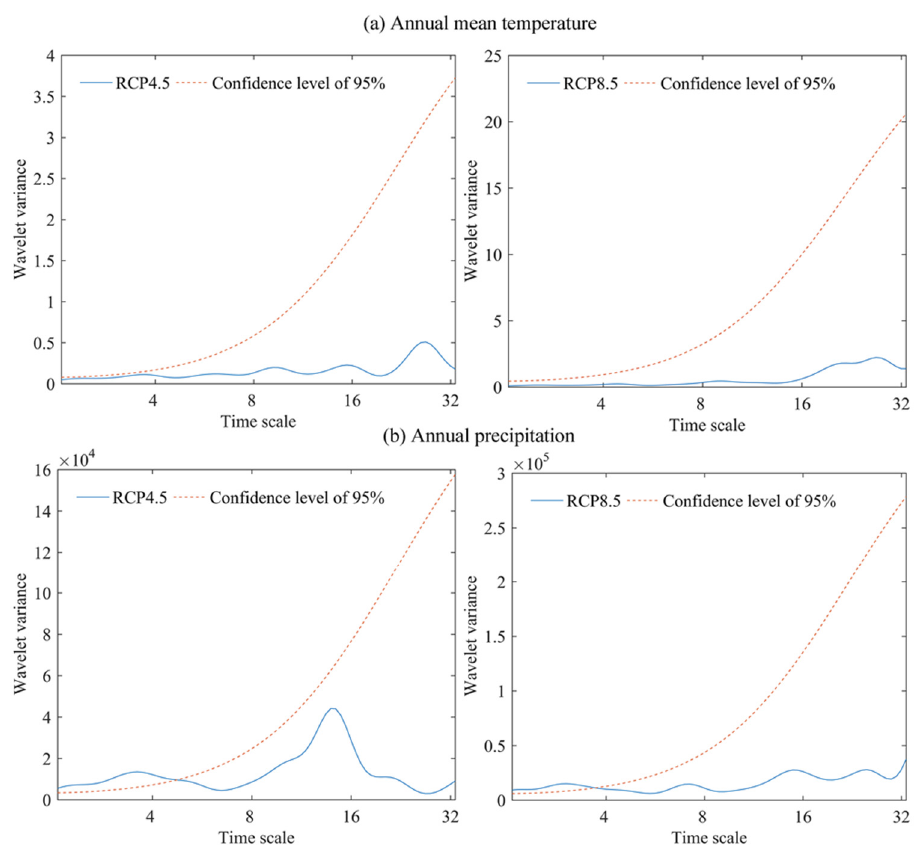
Figure 8. Wavelet analyses of the annual mean temperature and precipitation under the RCP4.5 and the RCP8.5.